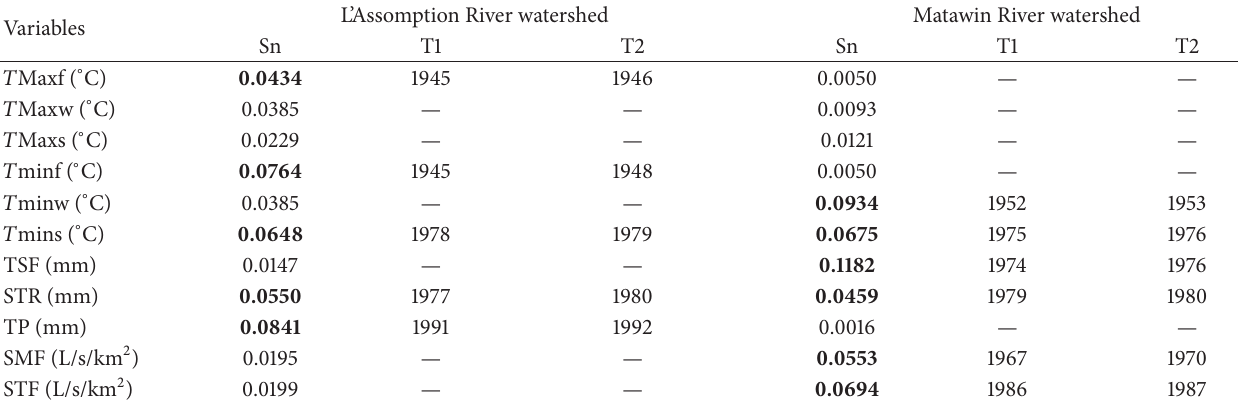
Table 2: Hydroclimate variables; results of the Lombard method analysis.